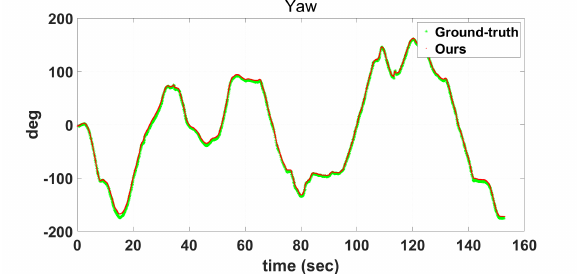
Figure 7. Comparison of our estimated yaw angle with the ground-truth for the home1 consequence.